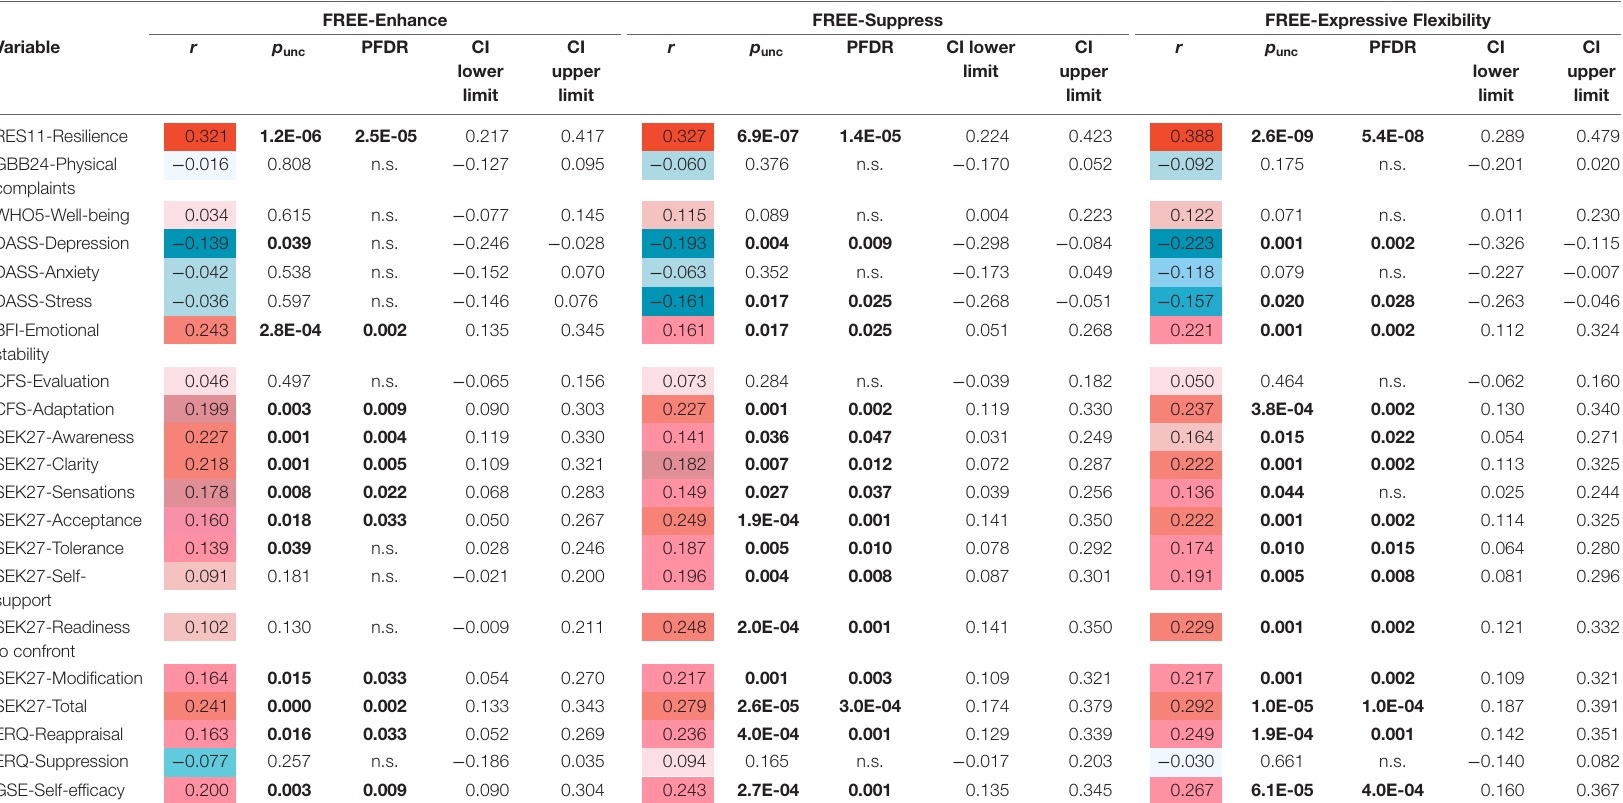
TABLE 4 | Rank correlations (including 95% confidence intervals) of suppress and enhance abilities and overall expressive flexibility (ef) with psychopathology, coping strategies, emotion regulation, well-being, and physical complaints.